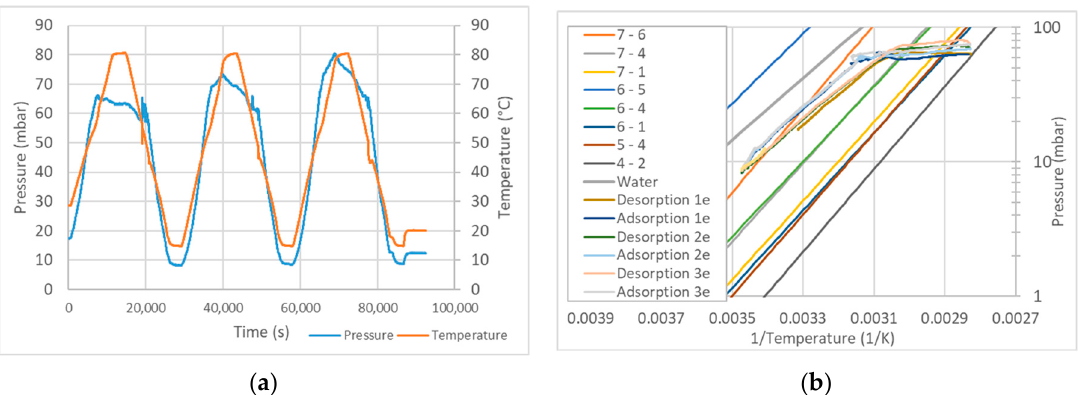
Figure 7. Example of a series of desorption-adsorption cycles with MgSO4 ( a ), compared with the van’t Hoff equation with data from Donkers et al. [28] ( b ).